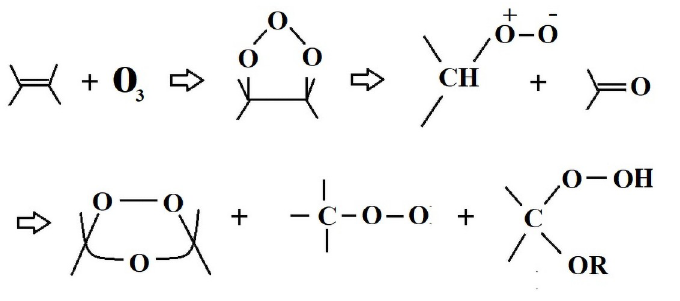
Fig 5. HC of samples for 9000